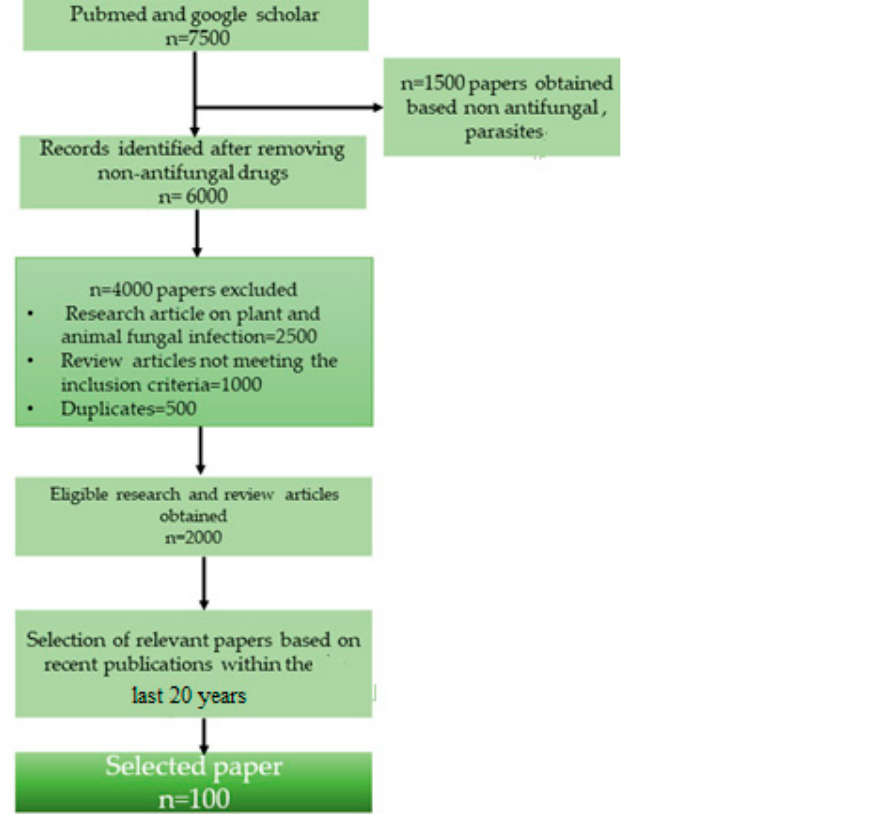
Figure 2. Flow chart exhibiting selection criteria adopted for selecting research publications used in the design and compilation of the present review.